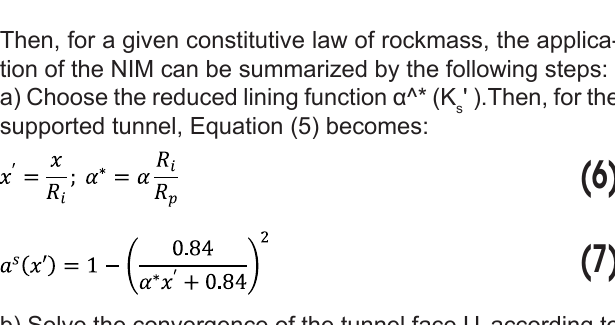
and Pressure P eq